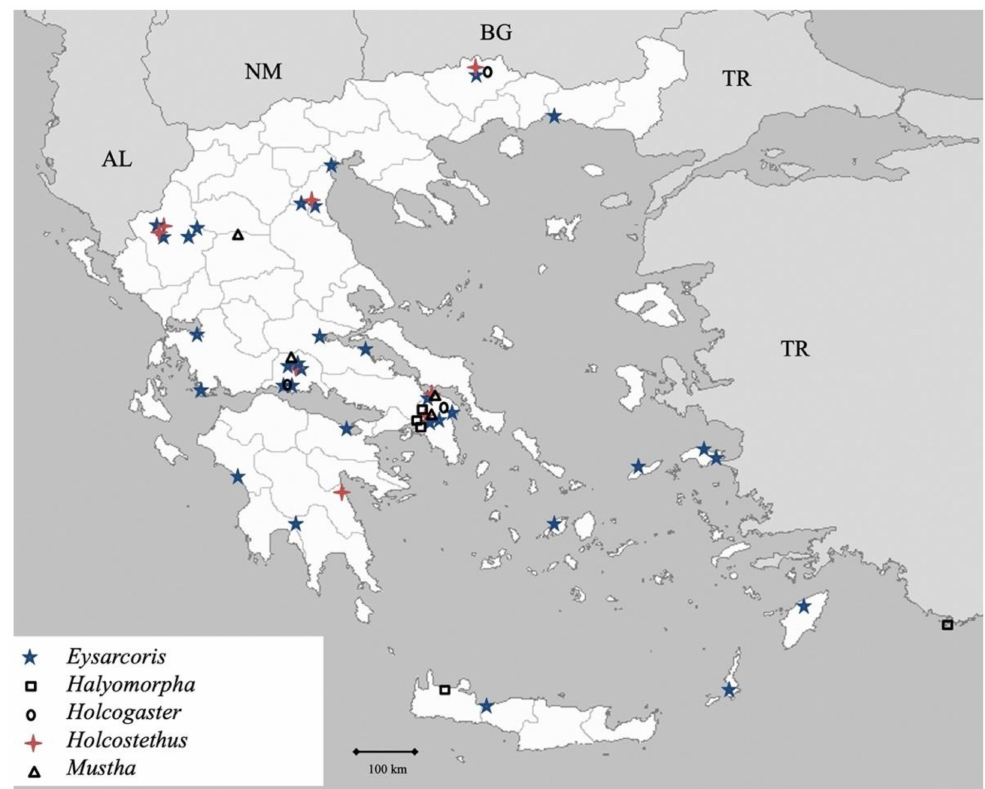
Figure 10. Map showing collecting sites of species of genera Eysarcoris, Halyomorpha, Holcogaster, Holcostethus and Mustha during the present study in